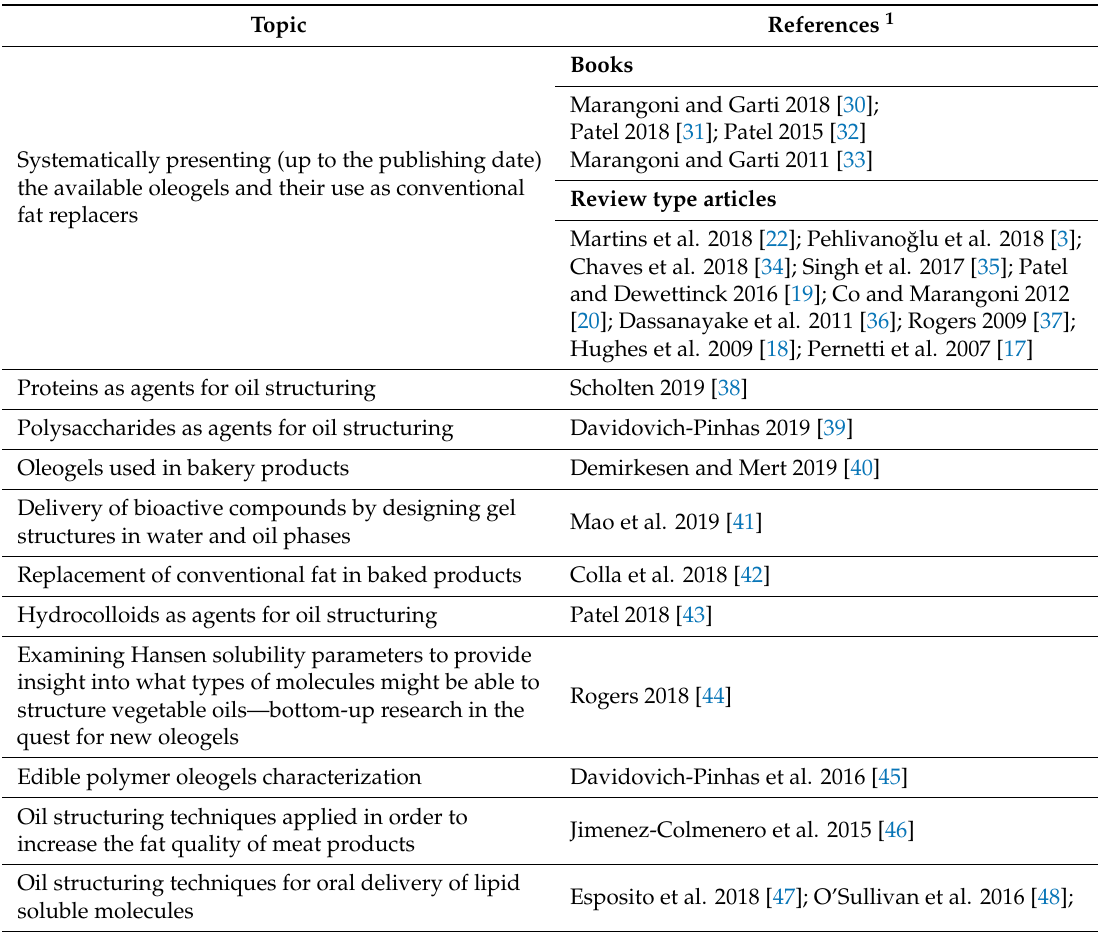
Table 1. Topics of books and selected reviews published on oleogelation